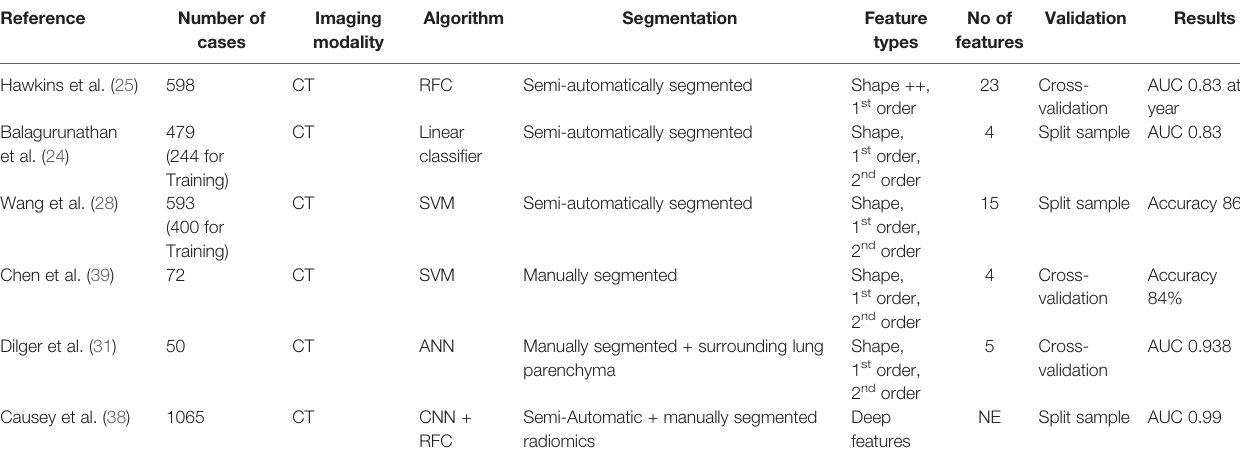
TABLE 1 | Mains studies regarding lung nodule prediction of